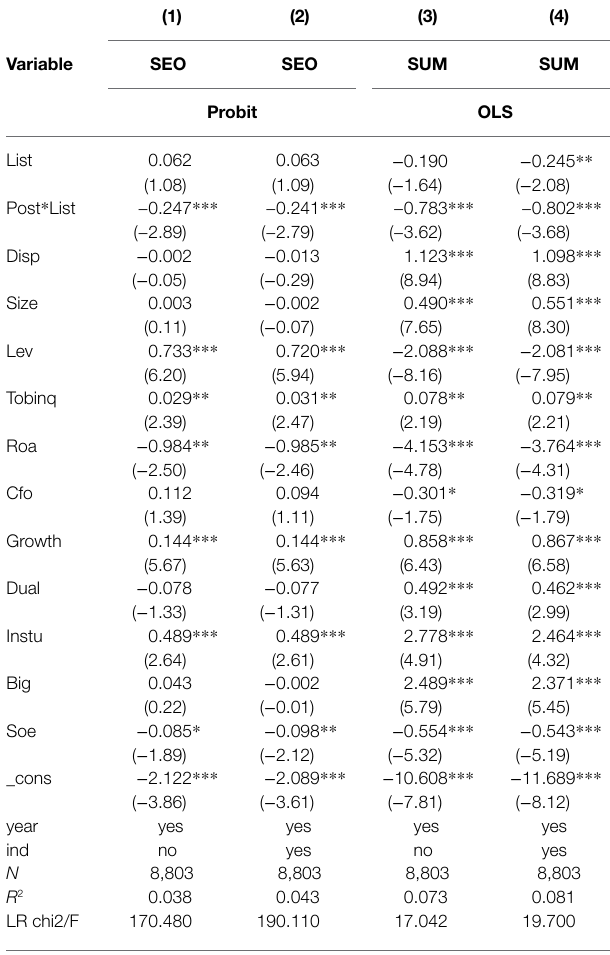
TABLE 3 | Relaxation of short-selling controls and private equity issuance by